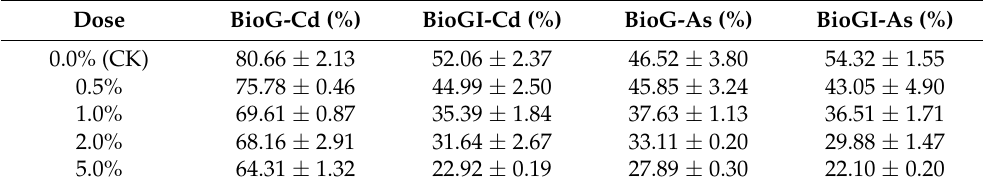
Table 3. Ca-humic complex lowers the bio-accessibility of soil Cd and As at simulated gastric (BioG) and intestinal (BioGI)